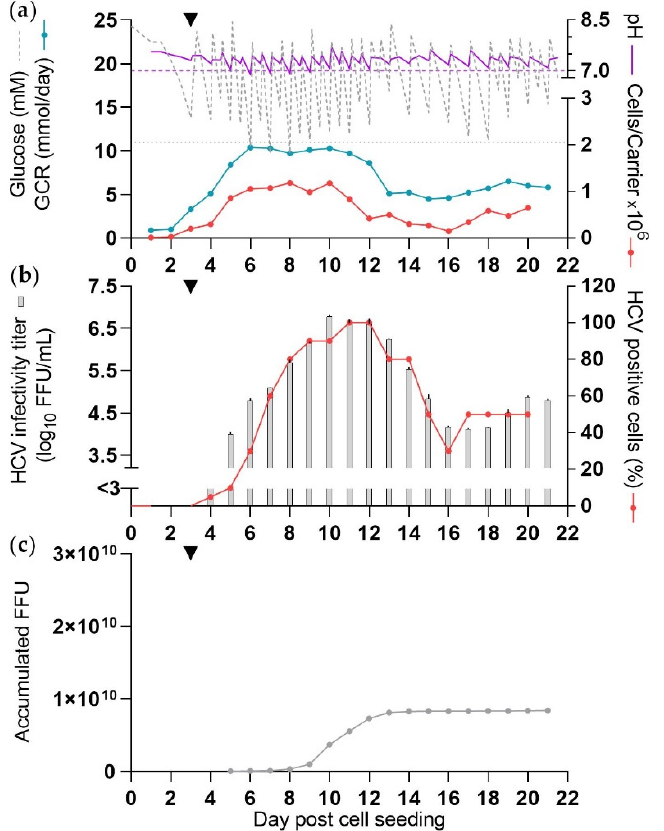
Figure 1. Production of HCV in SCM (CC-DMEx1-SCM). The culture was seeded with 2 × 10 ⁵ cells/carrier in SCM and infected with 1.1 × 10 ⁶ FFU at 3 dpcs (black arrow). Purple dashed line: pH 7, grey dotted line: 11 mM glucose. From 3 dpcs medium was exchanged each morning. At 4–12 dpcs glucose and/or NaHCO 3 solution was added as required upon DME and in the evening. Glucose concentration and pH were measured up to four times per day, each time before and after DME and/or addition of glucose and/or NaHCO 3 solution. Carriers were sampled daily for cell count. ( a ) Glucose concentration, pH, glucose consumption rate (GCR), and cells/carrier. ( b ) HCV infectivity titers shown as means of triplicates with standard errors of the means (SEM) and percentage HCV NS5A positive cells. ( c ) Accumulated focus forming units (FFU) calculated according to harvest volumes of 450 mL.